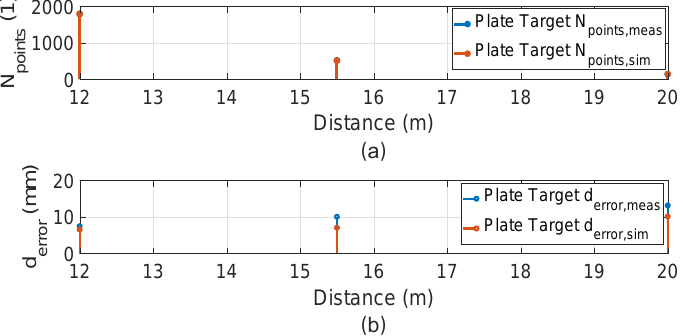
Figure 27. ( a ) Comparison of the number of points N points received from the surface of simu- lated and real 10% Lambertian plate. The simulation and real measurement results are consistent. ( b ) Comparison of real and virtual LiDAR sensor distance error d error for the plate target. The distance error d error is below MPE ± 20mm.